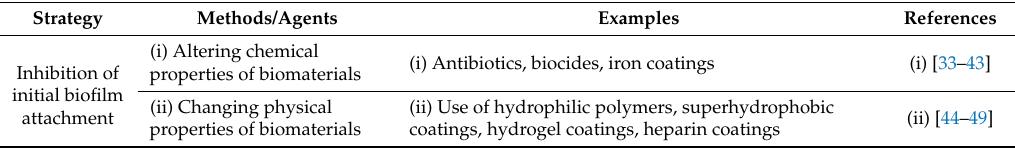
Table 1. Various strategies for the control of